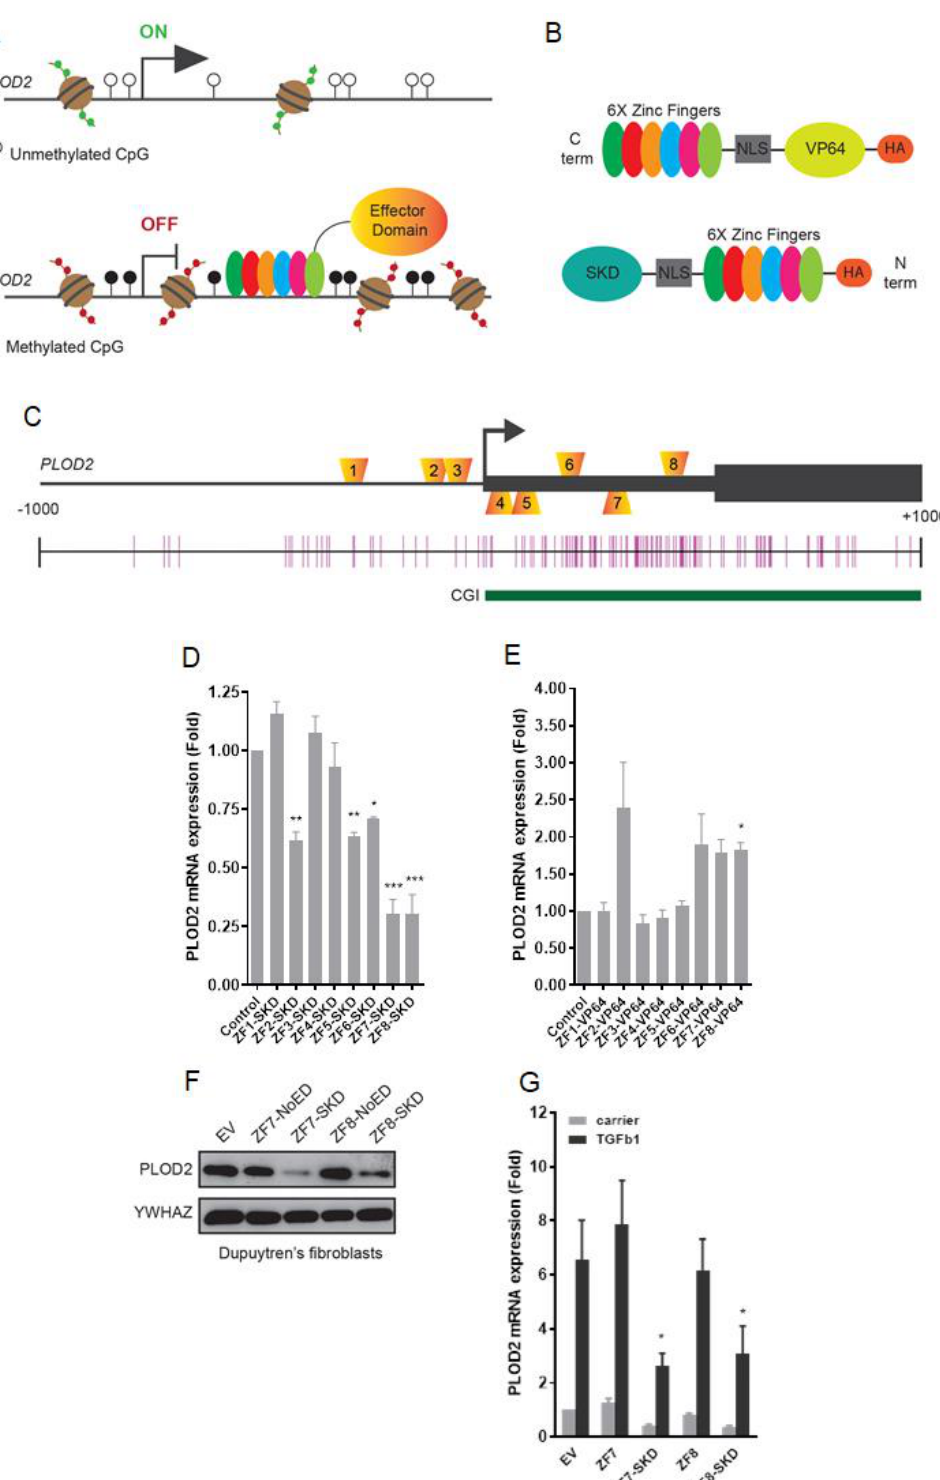
Figure 1. Screening of engineered transcriptional activators and repressors to target PLOD2 . ( A ) Schematic representation of the epigenetic editing strategy to modulate PLOD2 expression; ( B ) Schematic